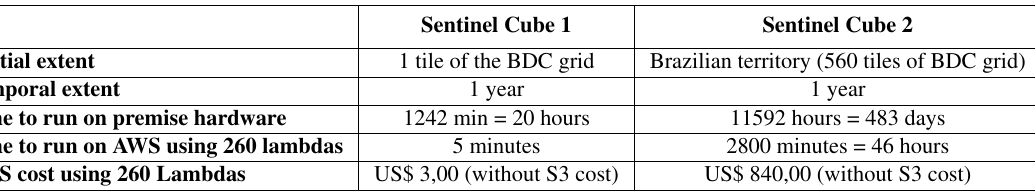
Table 1: Cost to generate a Sentinel-2 data cube.